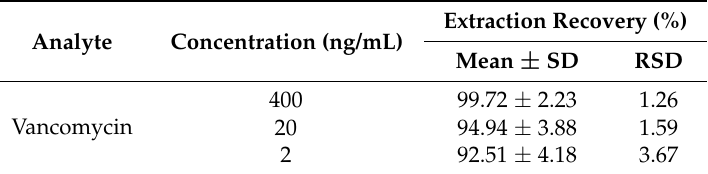
Table 2. Extraction recovery of vancomycin in serum.